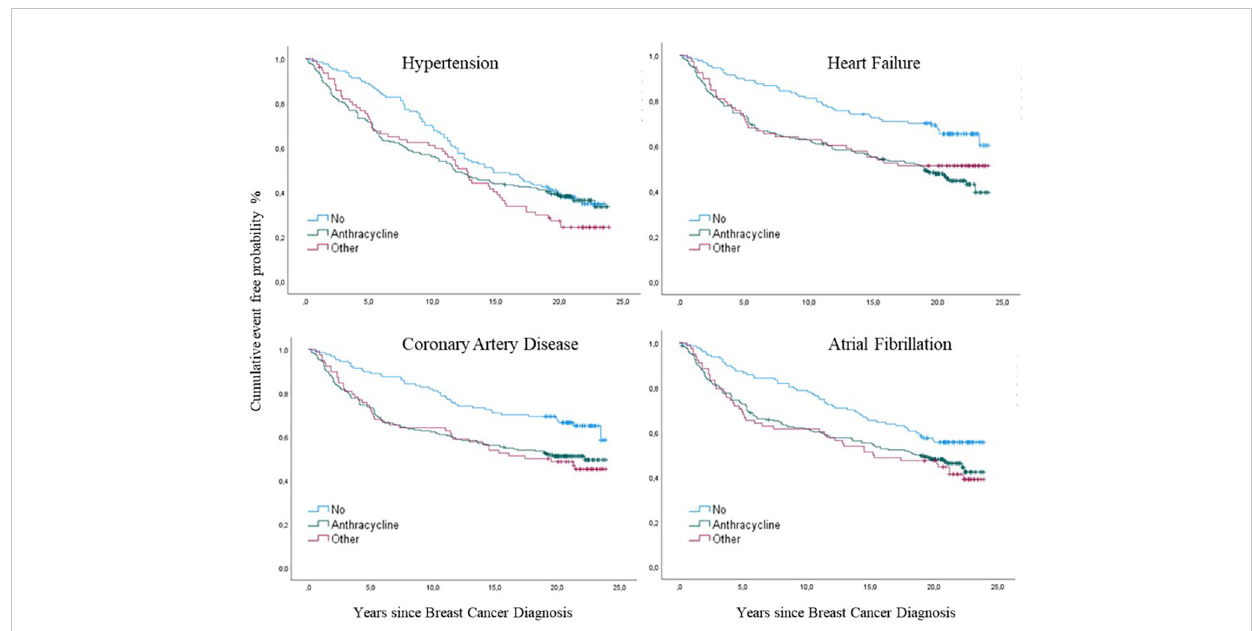
FIGURE 8 Cumulative incidences of cancer therapy-related cardiovascular toxicity (CTR-CVT); hypertension (HT), coronary artery disease (CAD), heart failure (HF) and atrial fi brillation (AF) by treatment group after breast cancer (BC) by years since diagnosis, with death as a competing risk in 433 patients with lymph node-positive early breast cancer at diagnosis in the Southeast Healthcare Region, Sweden, January 1, 1998, to December 31, 2002. Treatment groups were the anthracycline, the other Chemo, and the no Chemo groups.